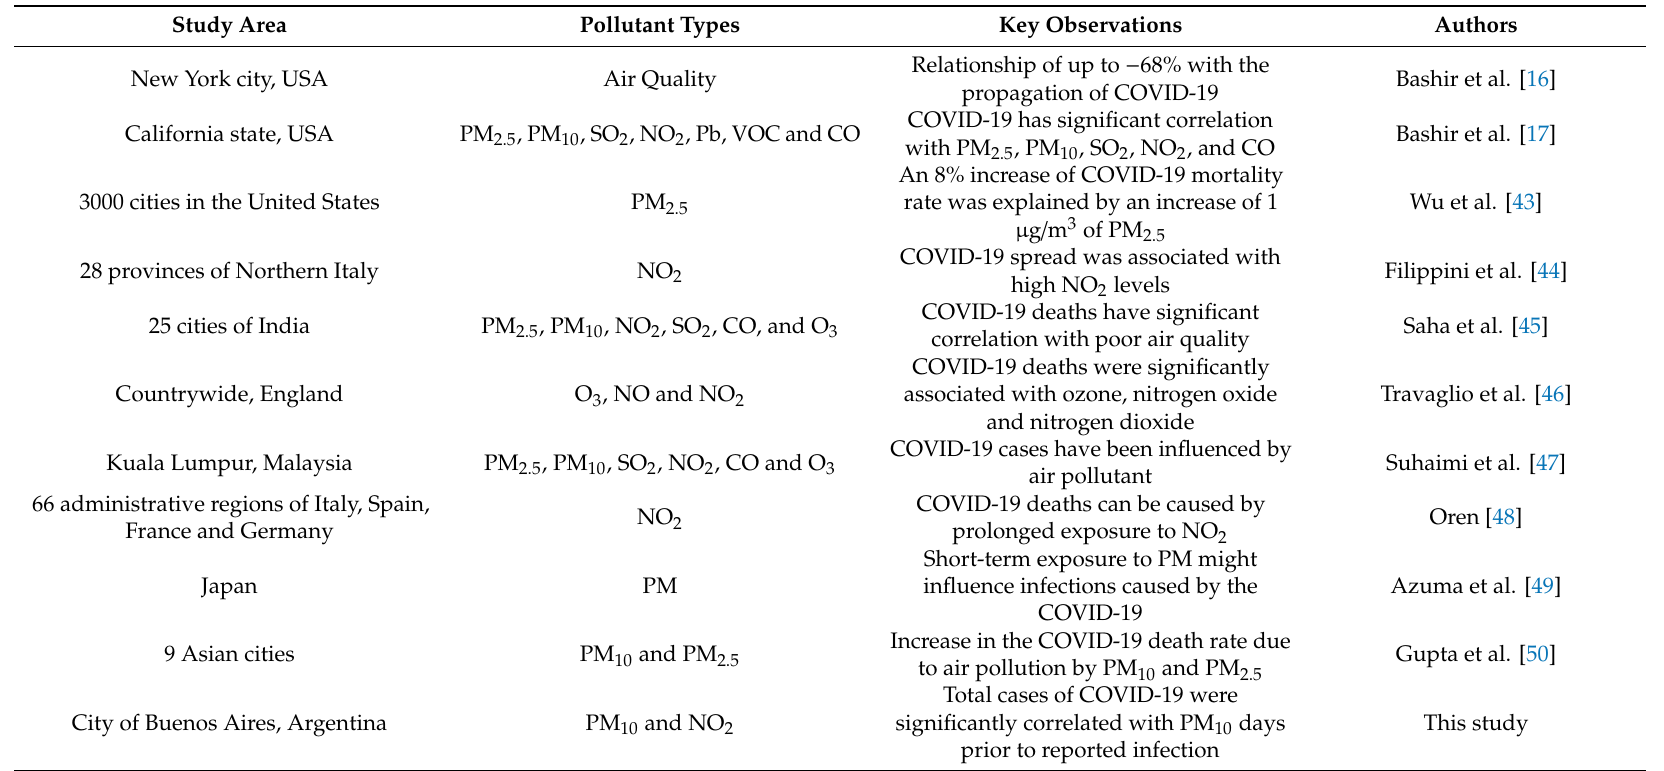
Table 1. Literature review of studies displaying the relationship between COVID-19 infections and mortality with atmospheric